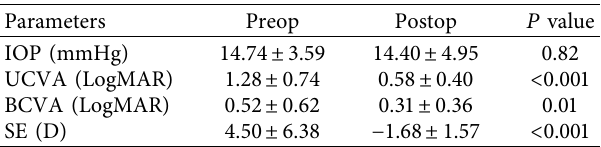
Table 2: Comparison of preoperative and postoperative clinical outcomes.